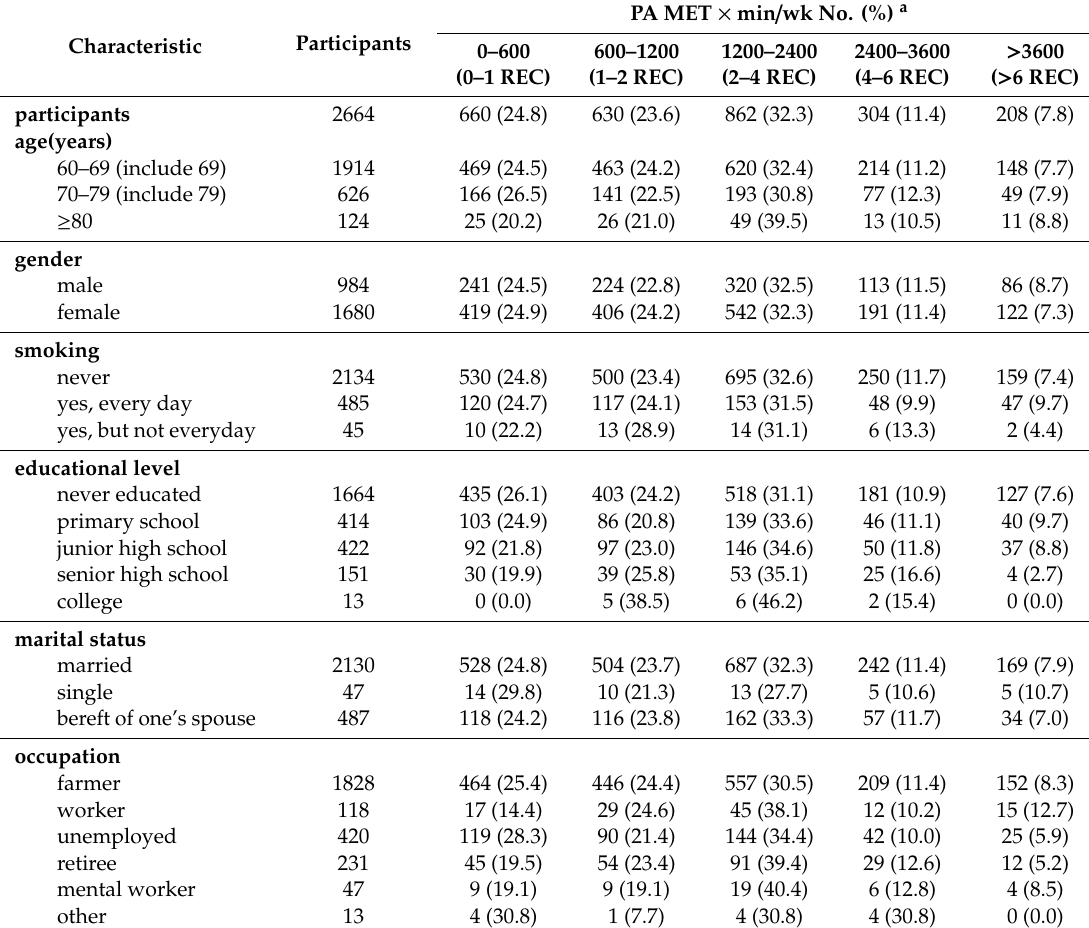
Table 1. Descriptive characteristics and physical activity of 2664